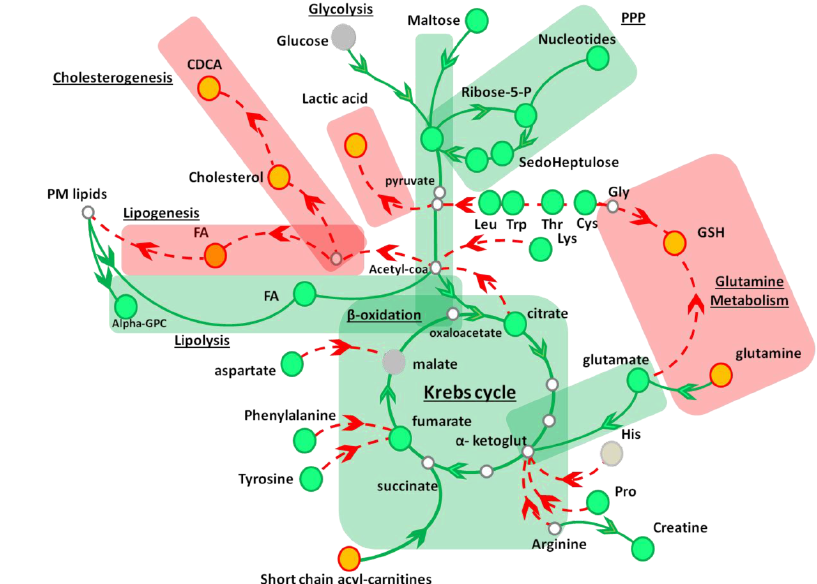
Figure 3. AAE influence on HuH7 metabolome. Schematic cartoon depicting some of the metabolic reactions positively (green boxes) or negatively (red boxes) affected by AAE in HuH7 cells. Red and green arrowheads indicate reactions halted or stimulated by AAE, respectively. Orange and green dots indicate metabolites whose intracellular levels resulted to be decreased or increased by treatment with AAE, respectively. (PPP, phosphate pentose pathway; CDCA, chenodeoxycholic acid; FA, fatty acids; PM lipids; plasma membrane lipids; GSH, reduced glutathione; Leu, leucine; Trp, tryptophan; Thr, threonine; Cys, cysteine; Gly, glycine; Lys, lysine; His, histidine; Pro, proline; alpha-GPC, glyceryl phosphoryl choline).